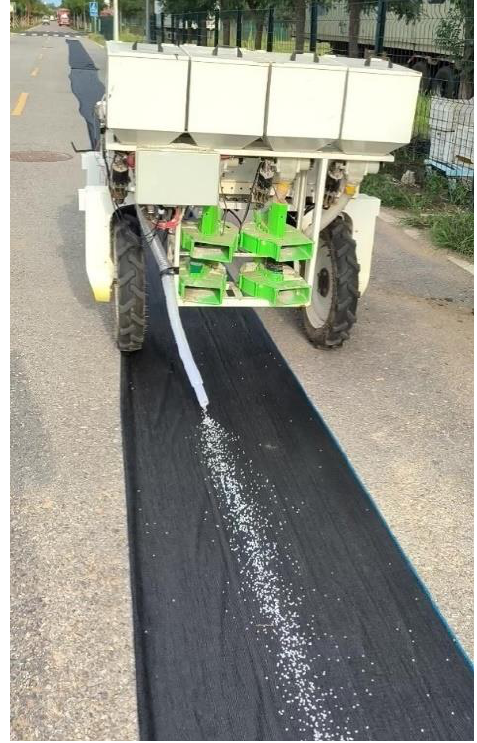
Figure 9. Variable-rate fertilization